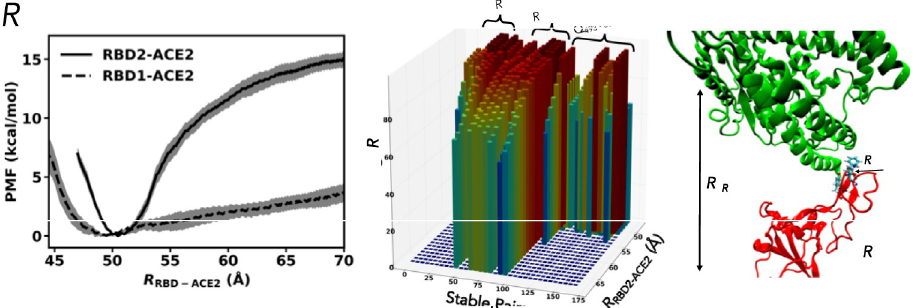
Fig 4. (A) Free-energy profiles computed from US simulations as function of R RBD-ACE2 using C36-FF. (B) Three- dimension distributions of the stable pairs (refer Fig 2) as function of the biasing distance between the centers of mass of RBD2 and ACE2. (C) A snapshot during the Umbrella simulations using R RBD-ACE2 = 70 Å . Residue A475 in RBD2 is located right behind